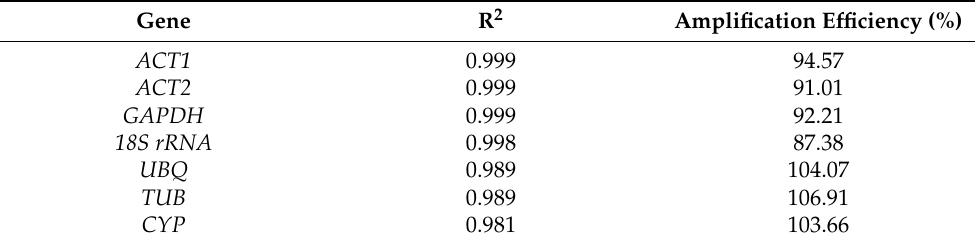
Table 2. Amplification efficiency of candidate reference genes.